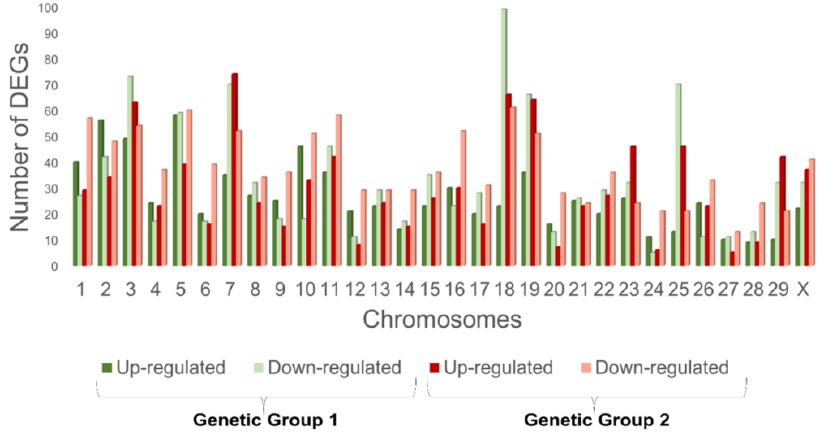
Figure 1. Distribution of the differentially-expressed genes across the chromosomes in G1 and G2.